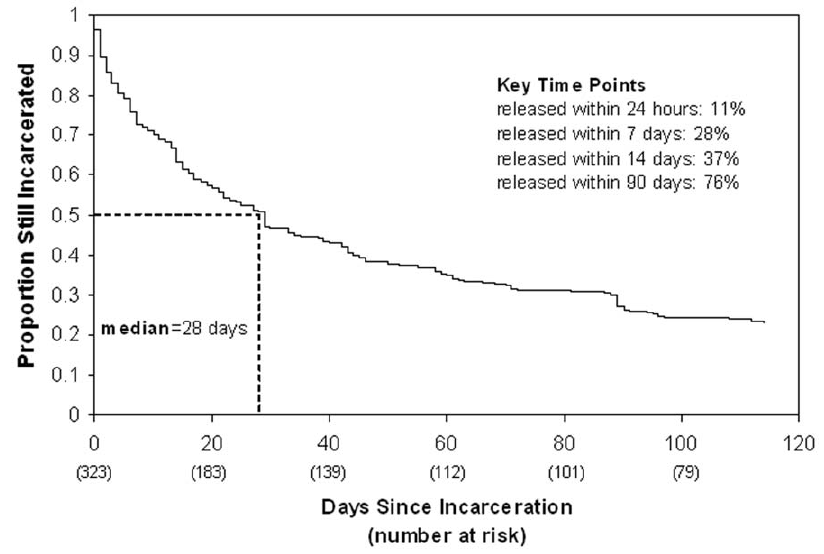
Figure 3. Time to Release Following Incarceration. doi:10.1371/journal.pone.0007648.g003 PLoS ONE |